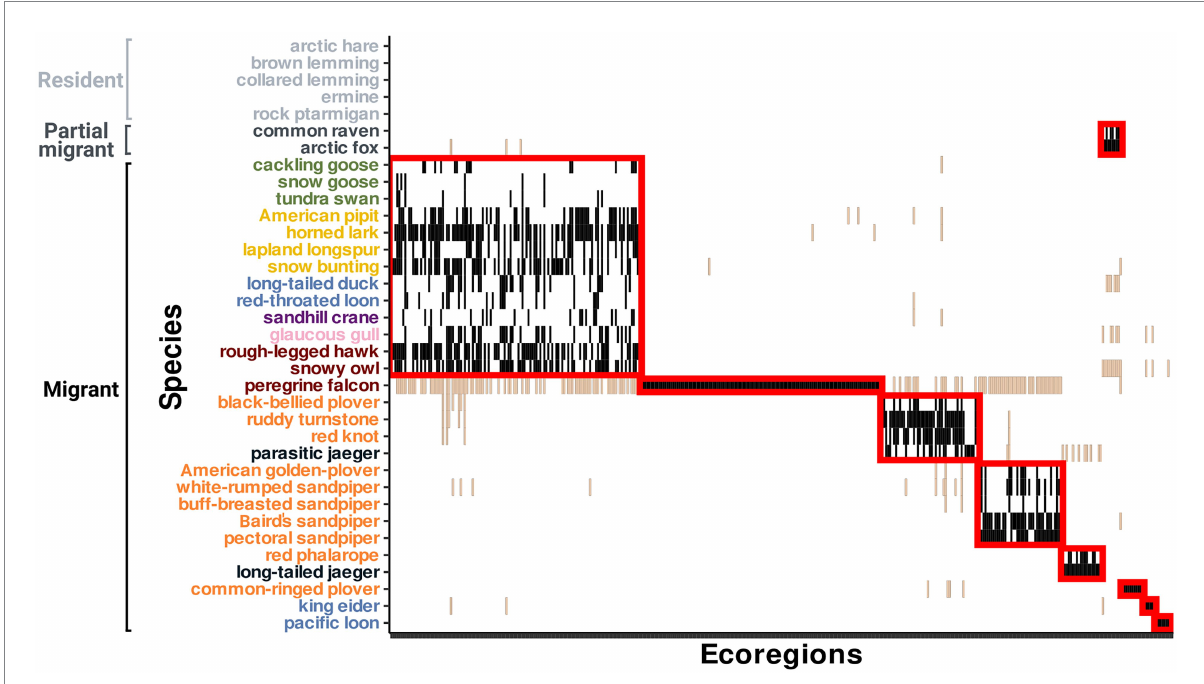
FIGURE 6 Partition of the Bylot Island community migration network with the highest modularity based on the infomapecology algorithm ( M = 6.32, p < 0.001), with nine modules of species and ecoregions sharing more edges between them than with other species and ecoregions of the network. Modules are represented by red boxes and can include multiple ecoregions and species. Interactions non-associated with a module are represented in light brown and are not included in boxes. Species and ecoregions are ordered by modules and species labels are colored by functional groups (red = raptors, pink = gulls, purple = cranes, dark blue = jaegers, light blue = ducks and loons, orange = shorebirds, yellow = passerines, green = geese and